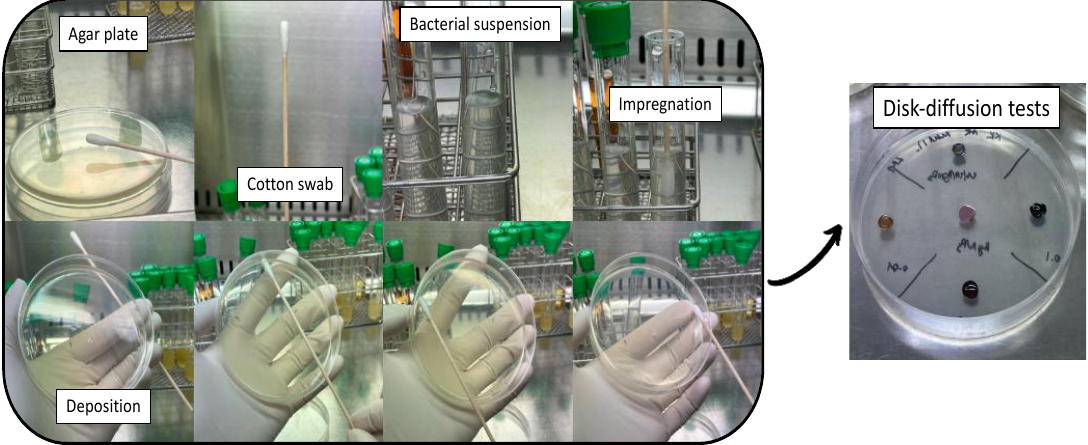
Figure 14. Preparation of the samples for the disk diffusion assay.